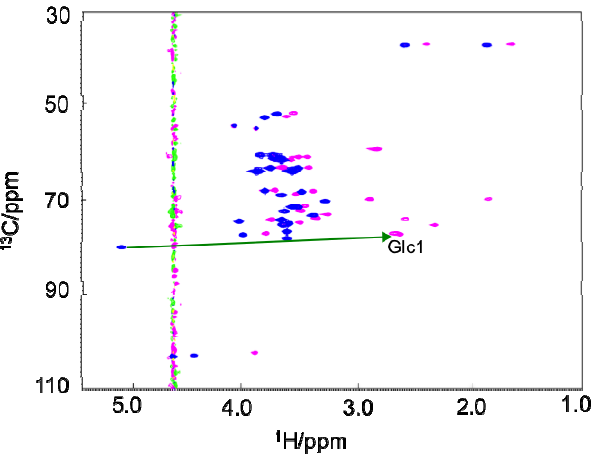
Figure 2. 1 H- 13 C HSQC spectra of the GM2 tetrasaccharide tagged with Tm 3+ (magenta) and La 3+ (blue).